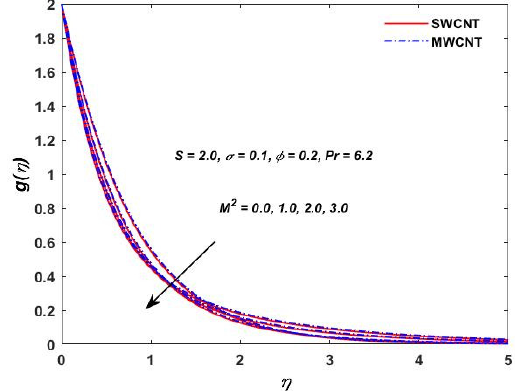
Figure 2. Magnetic parameter verses velocity 𝑓 (cid:4593) (𝜂).